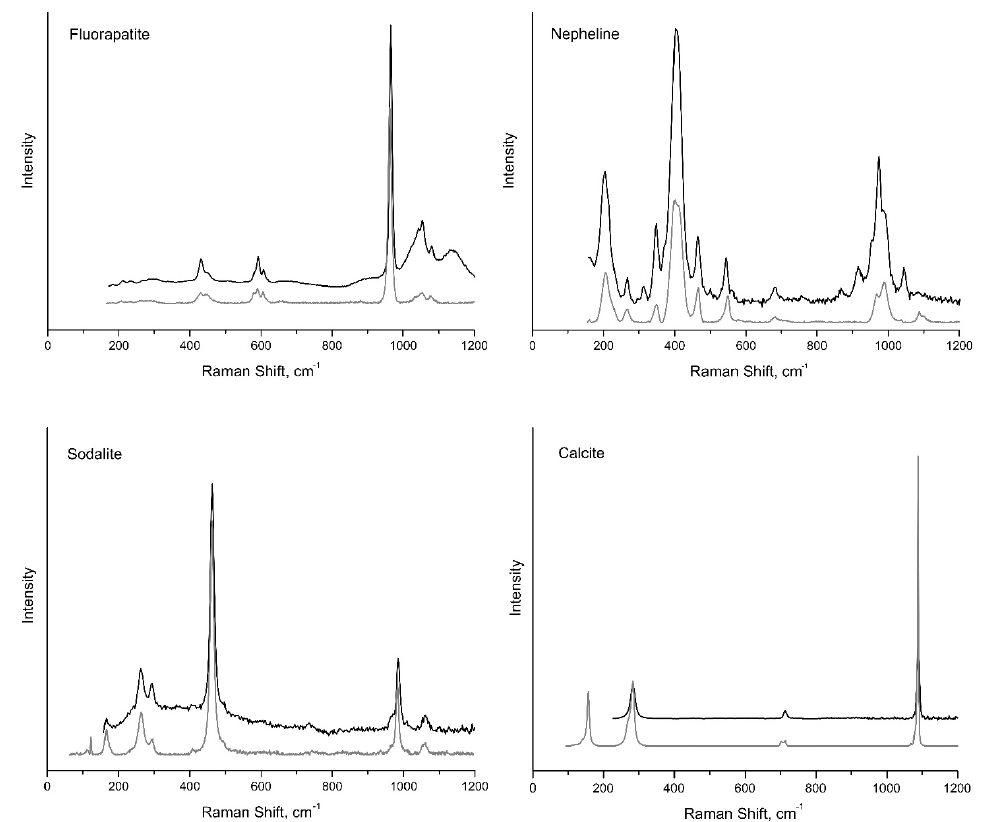
Figure 3. Raman spectra of minerals: black spectra—this research, grey spectra—RRUFF database (fluorapatite R060333, nepheline R090059, sodalite R060354, calcite R150075).